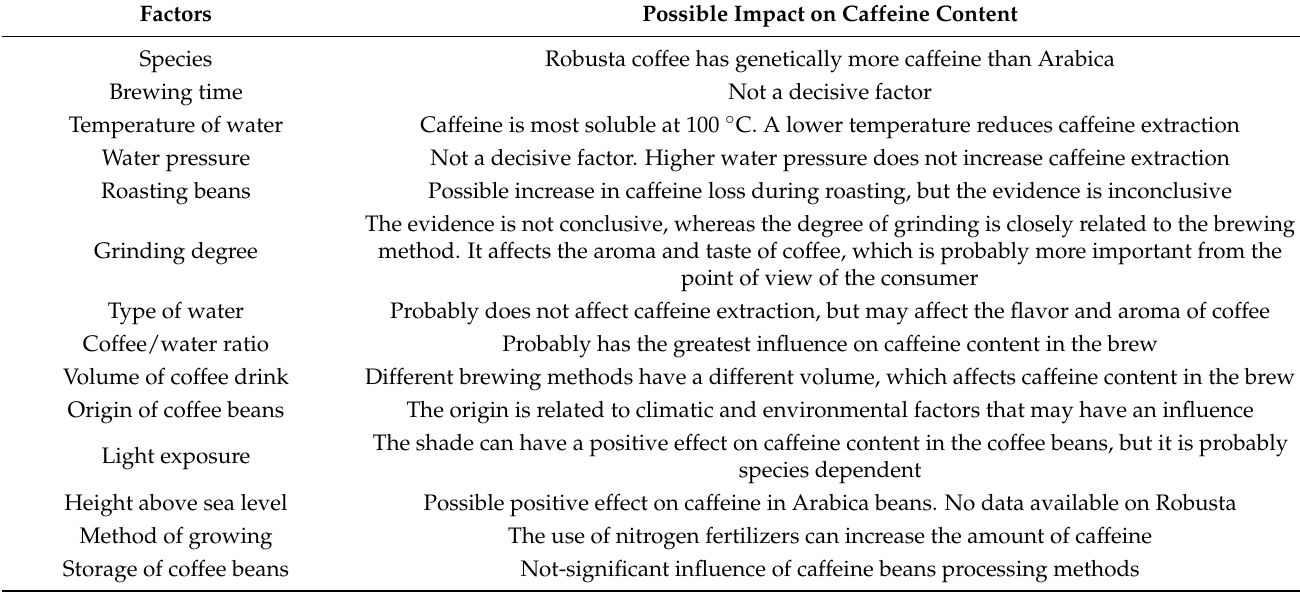
Table 4. Factors influencing caffeine content in coffee